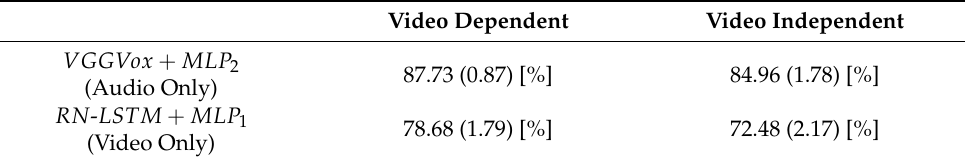
Table 3. Audio/video results using the AVA-ActiveSpeaker videos with respect to Mean Accuracy (Standard